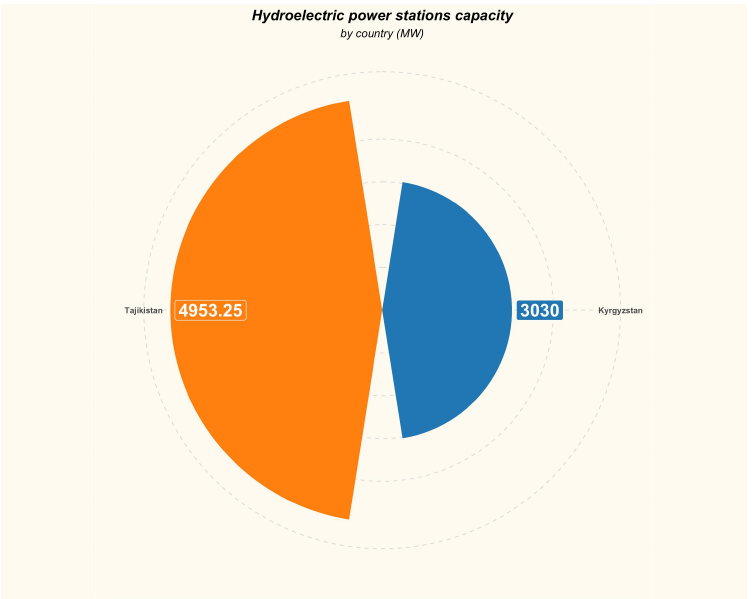
Figure 4. Hydroelectric power station capacities in Tajikistan and Kyrgyzstan. Data source: Investicii v vodno-jenergeticheskij kompleks Central’noj Azii, Evrazijskij Bank Razvitija, Almaty 2021, p.